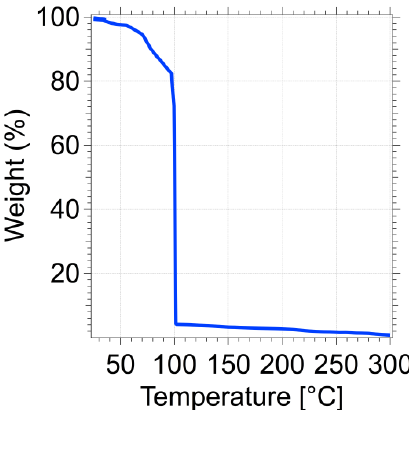
Figure 6. Water-loaded cantilever. Variation in the percentage weight of the water drop as a function of the